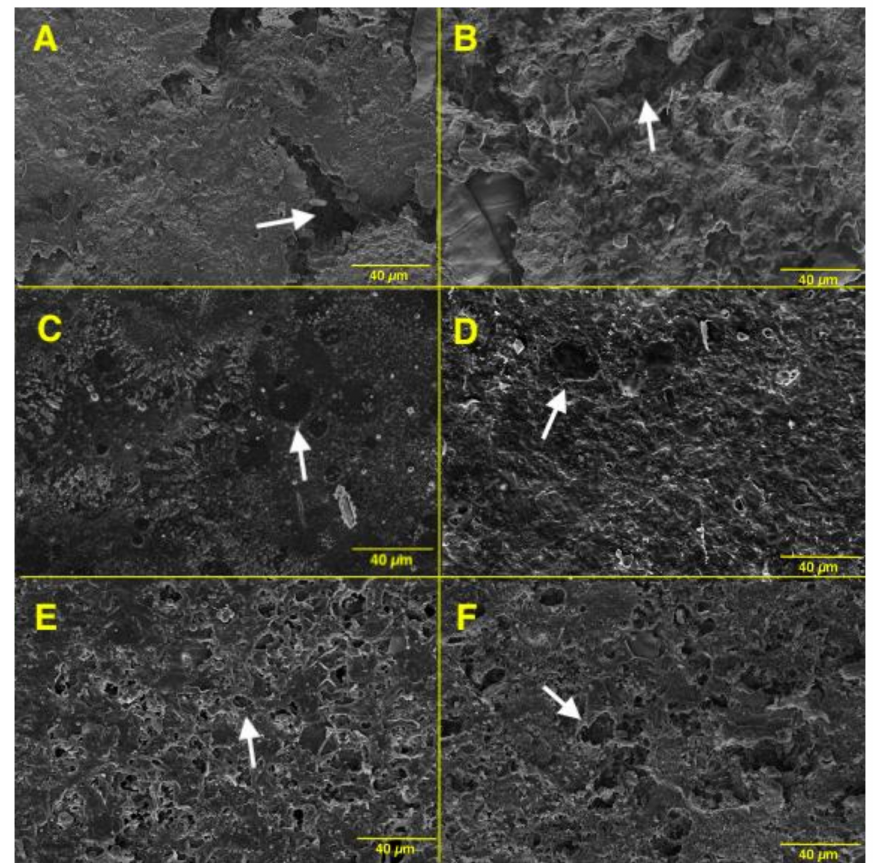
Figure 5. SEM micrographs of the different lyophilized bioplastics observed ( A ) RBS; ( B ) RBG; ( C ) DRBS; ( D ) DRBG; ( E ) FRBS; ( F )